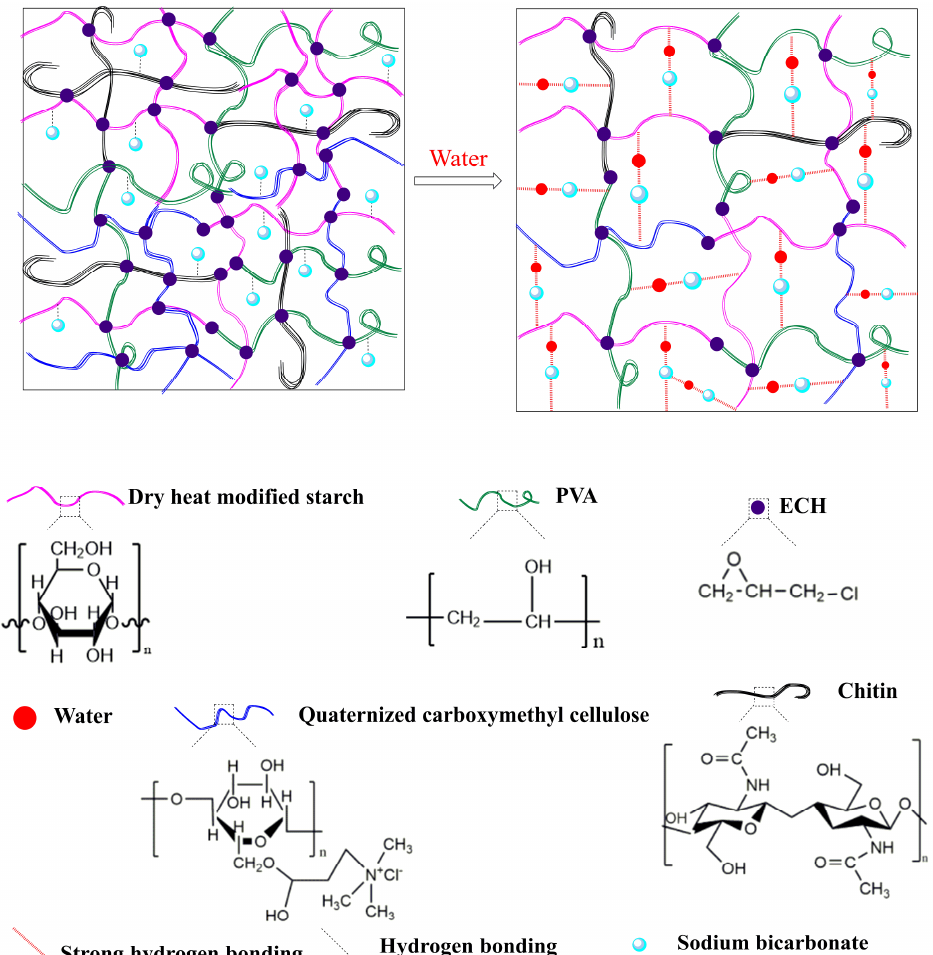
Figure 1. A schematic diagram of the structure and mechanism of acid- and alkali-resistant hydro- gels